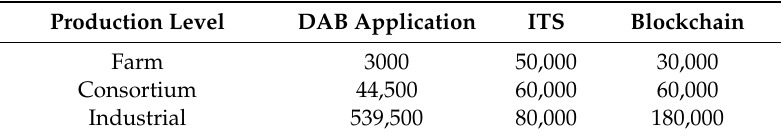
Table 5. Investment cost of the Dispositivo Antimanomissione per Bottiglie (DAB) application machine, software for the infotracing technologies systems (ITS) and blockchain costs in relation to the three production levels (in €